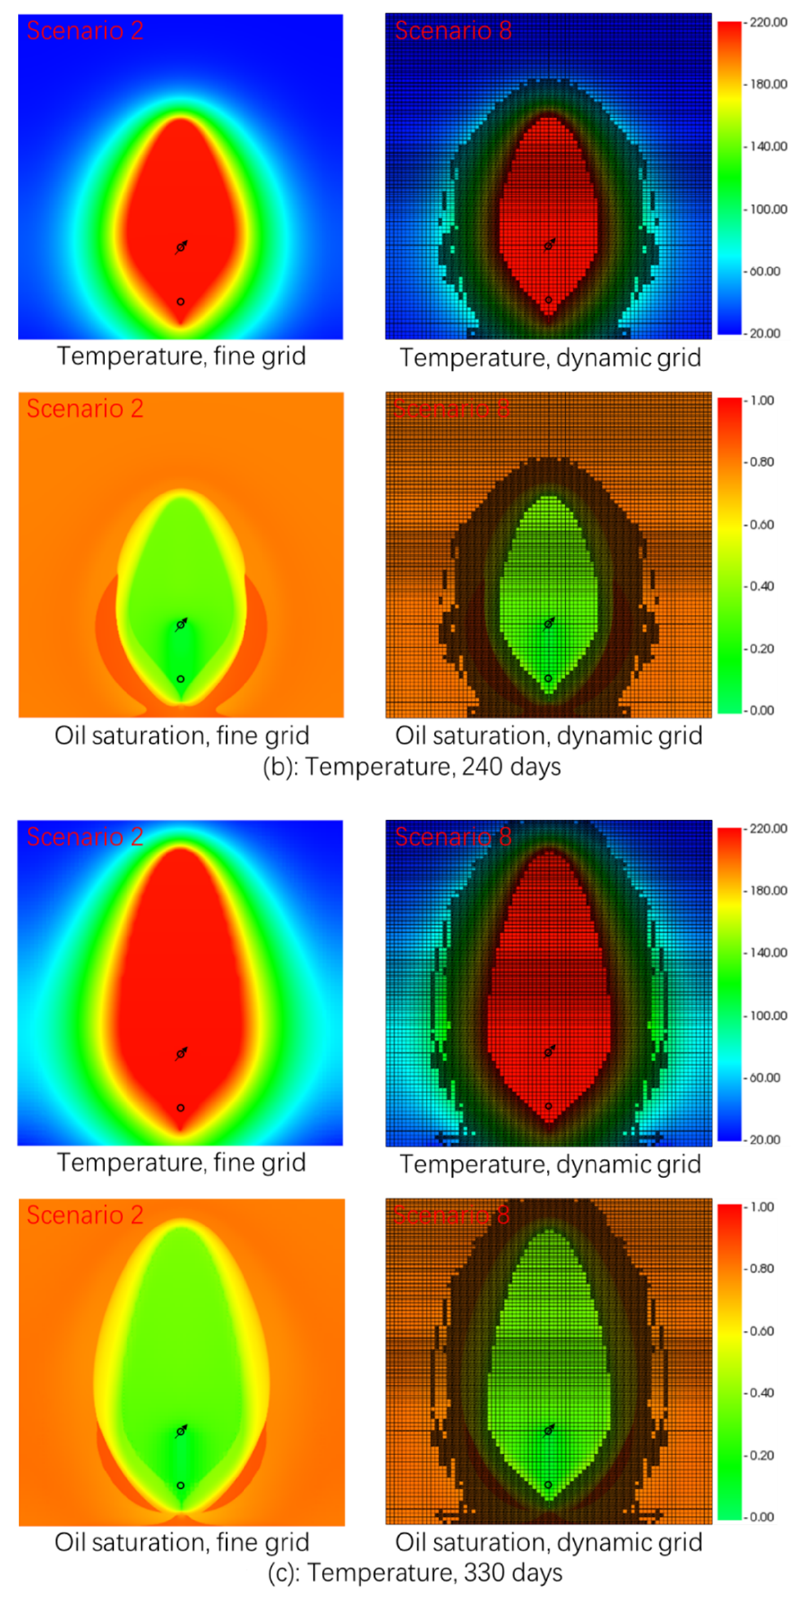
Figure 8. Cross-sectional temperature and oil saturation distributions of scenarios 2 and 8 at ( a ) 150 days, ( b ) 240 days and ( c ) 330